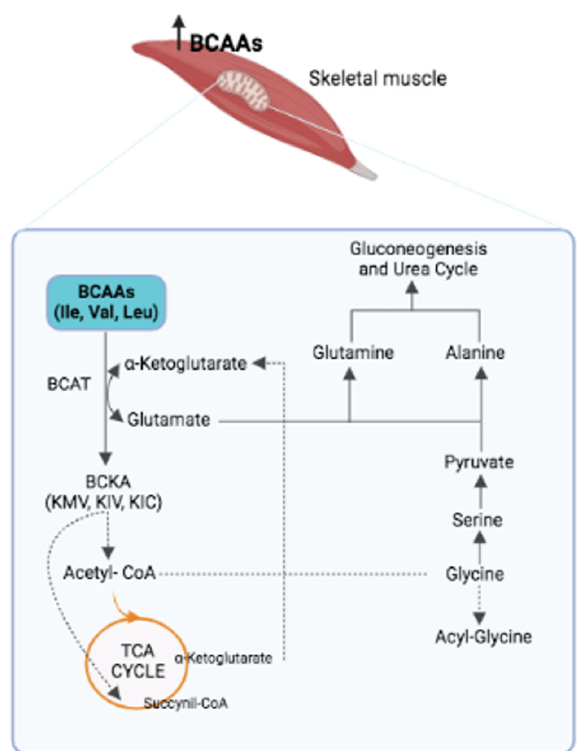
Figure 1. The first step in the catabolism of BCAAs is their transamination by the BCAT enzyme, which leads to three branched-chain keto acids (BCKAs): α -ketoisocaproic acid (KIC), 2-oxoisovalerate (KIV) and α -keto- β -methyl-n-valeric acid (KMV). At the same time, the amino group of each BCAA is transferred to the α -ketoglutarate to produce glutamate as nitrogen source, which, in turn, is converted into glutamine (by the glutamine synthase) and alanine (by the alanine transaminase), which enter the urea cycle and gluconeogenic pathways. This metabolic process leads to a reduced presence of glycine, which is transformed into serine, pyruvate and, finally, into glutamine and alanine. This process explains why high levels of BCAAs in IR are associated with low